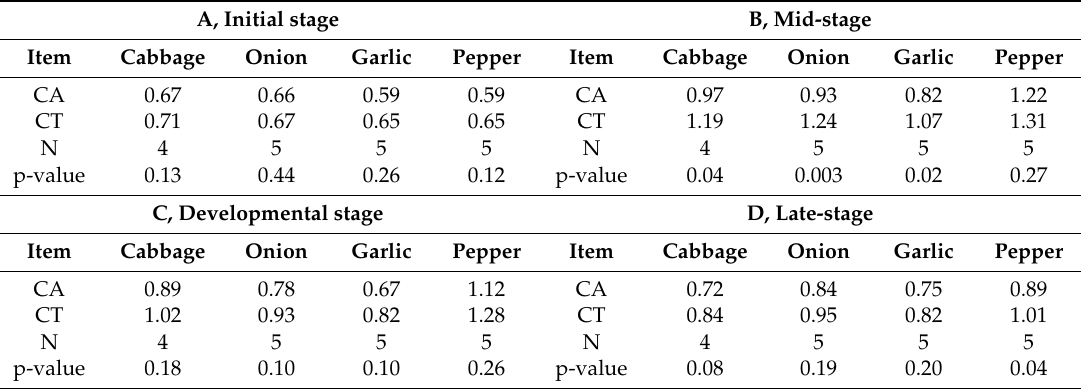
Table A4. A one tailed paired t-test of crop coe ffi cient values of di ff erent vegetables under their respective growth stages at 5% significance level.